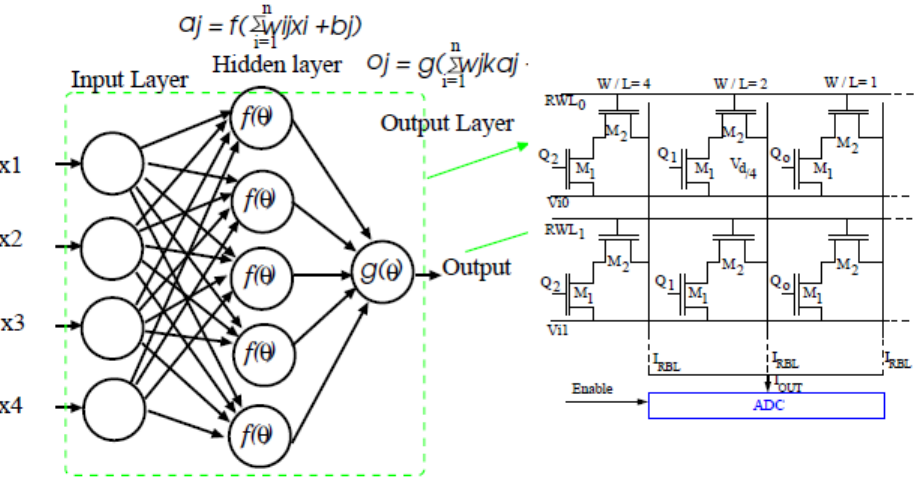
Figure 1. Basic CNN architecture and use of built-in computational